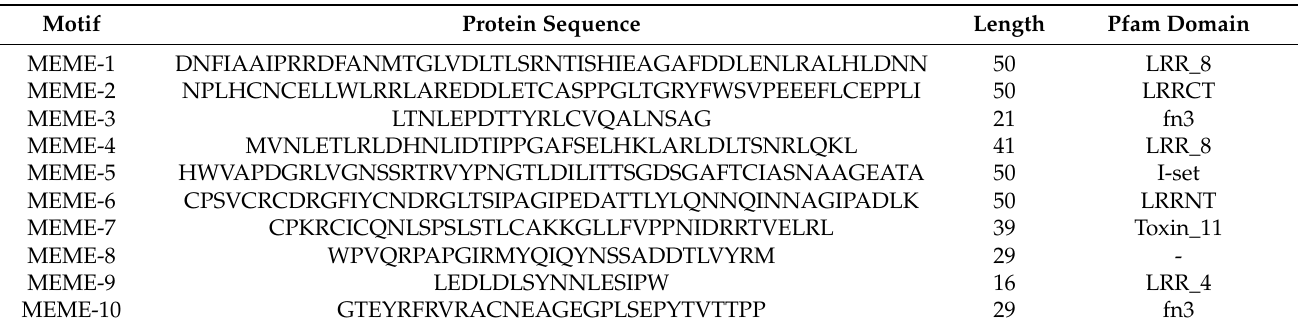
Table 2. Ten differentially conserved motifs detected in FN-III genes family in